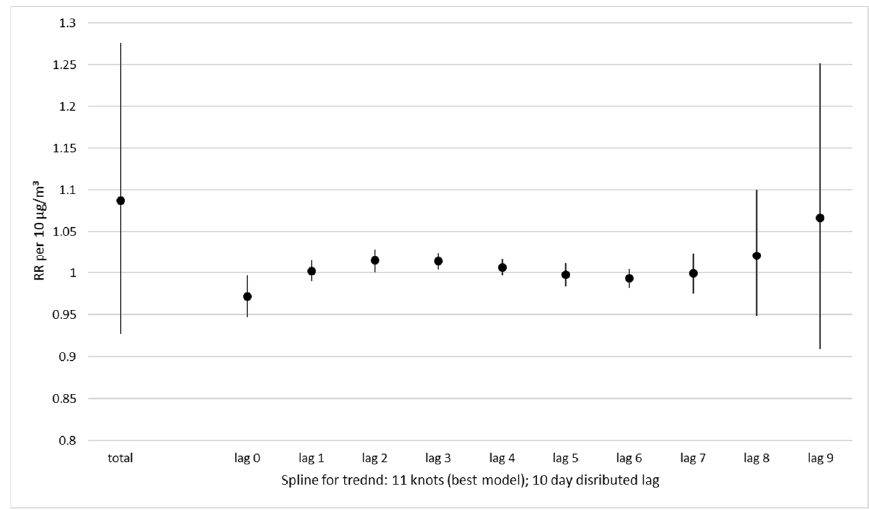
Figure A2. Sensitivity analysis: Effect (relative risk and 95% confidence interval) on stationary hos ‐ pital admissions per 10 μ g/m³ increase in PM2.5, total effect and daily effects over 7 consecutive days (lag 0–6): Optimal model (11 knots for the time smoother) compared to 16 and 6 knots for the 3 ‐ year period.